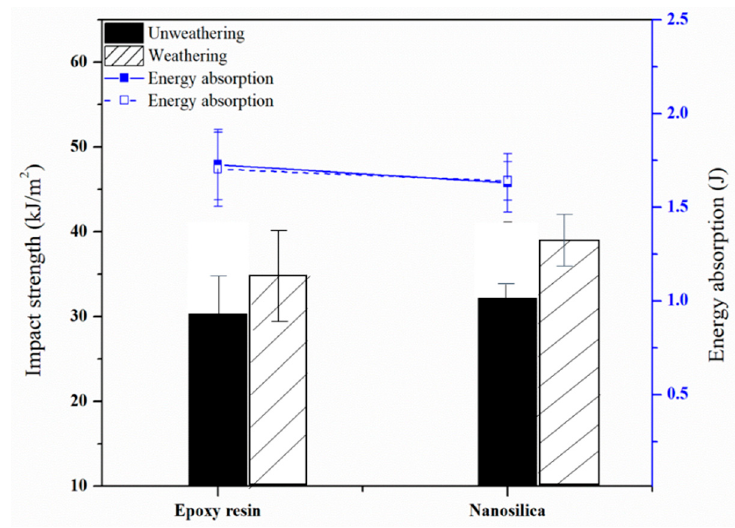
Figure 5. Impact strength of nanocomposites-fiber samples after accelerated aging.